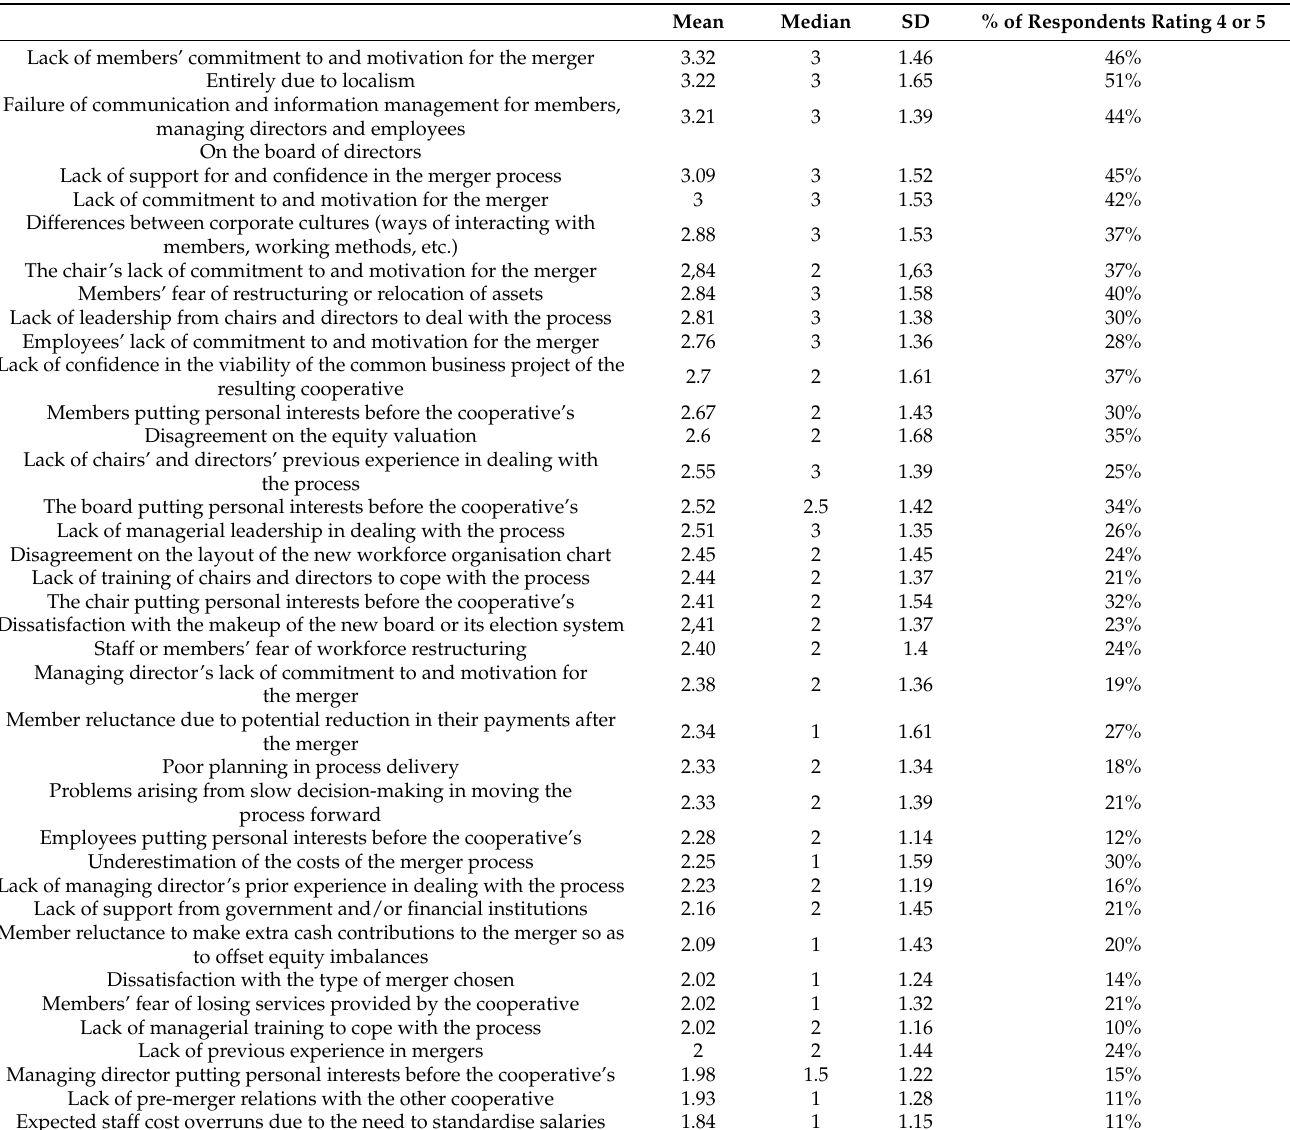
Table 5. Responses on the assessment of the reasons why the merger between cooperatives did not succeed, ranked from most to least perceived